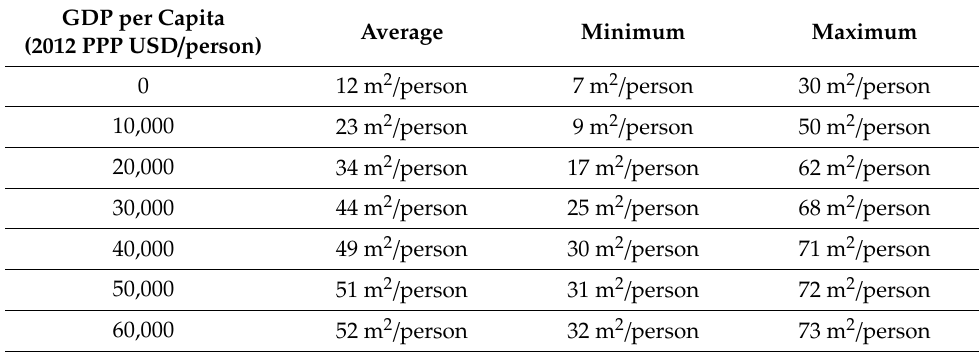
Table 4. Residential floor area per capita as a function of GDP per capita